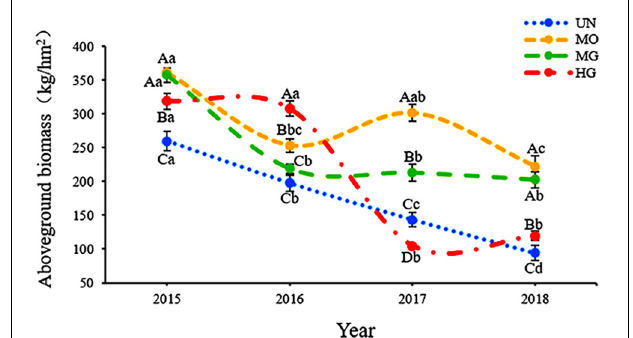
FIGURE 1 | Interannual variation in grassland plant biomass under different utilization patterns. Different capital letters indicate significant differences in plant biomass among sites in the same year at the 0.05 level, and different lowercase letters indicate significant differences in plant biomass between years within a